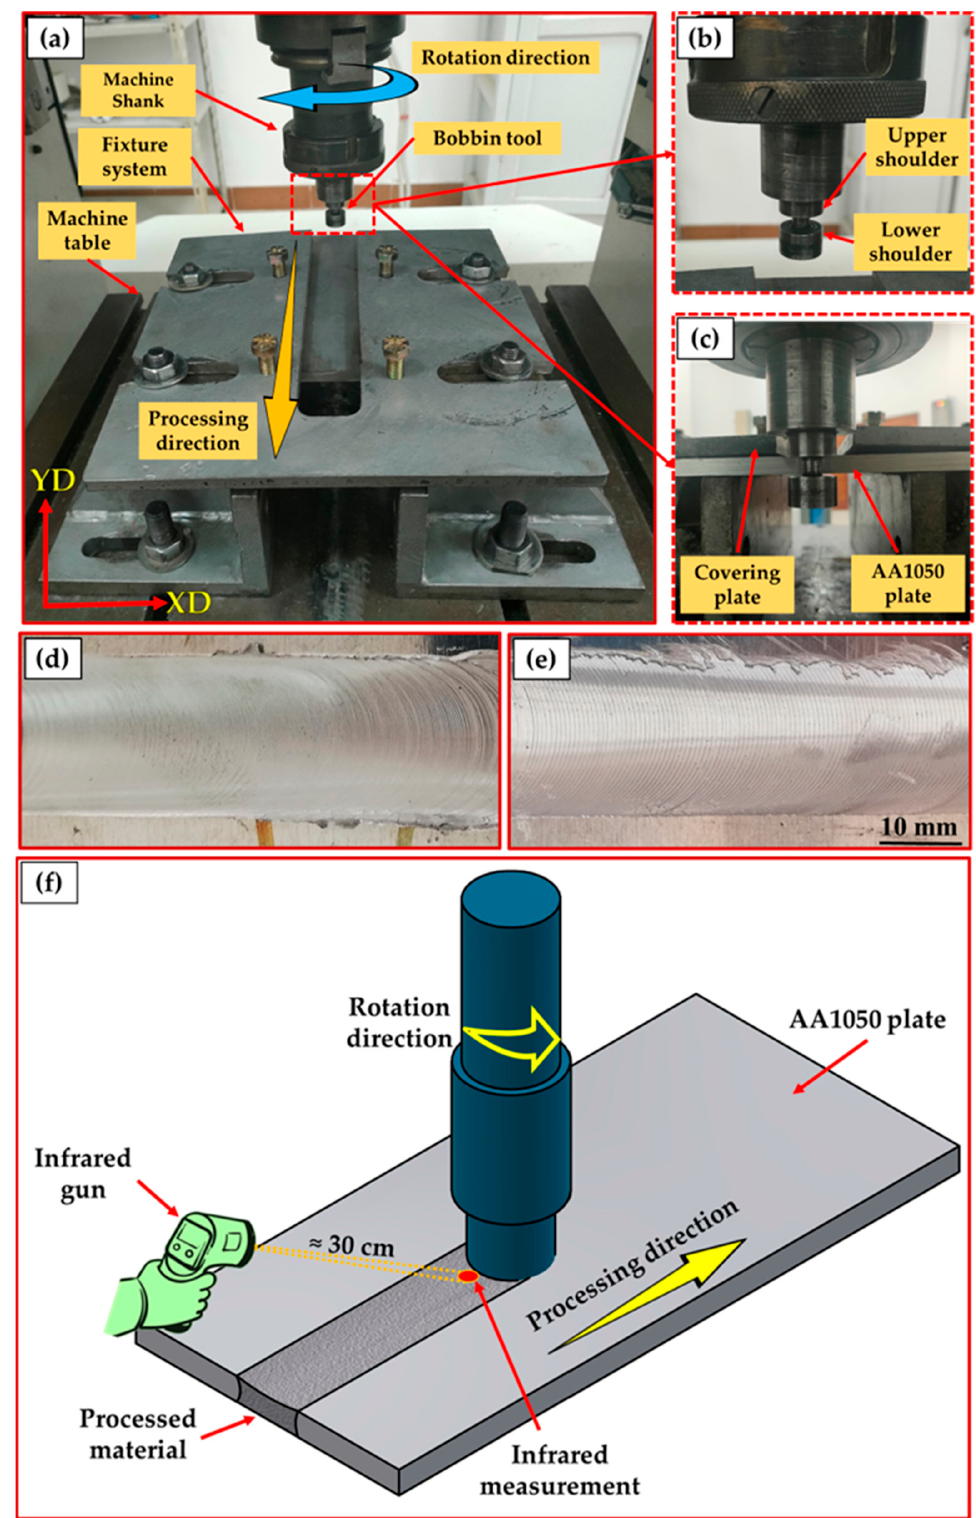
Figure 2. ( a , b ) Front images of the BT-FSP setup configuration, ( c ) back view of the BT location before processing, and example of ( d ) the upper and ( e ) lower surface of a processed specimen. ( f ) A schematic showing measuring temperature in the PZ using an infrared thermometer. The influence of processing travel speed and pin geometry on BT-FSP of AA1050 was investigated using different travel speeds of 50, 100, 200, and 300 mm/min and different pin geometries of triangular (Tr), cylindrical (Cy), and square (Sq) at a constant rotation speed of 600 rpm. The plunge depth of both the upper and lower tool shoulders was con- stant and set to be 0.2 mm. The dimensions of the top and the bottom shoulders have the